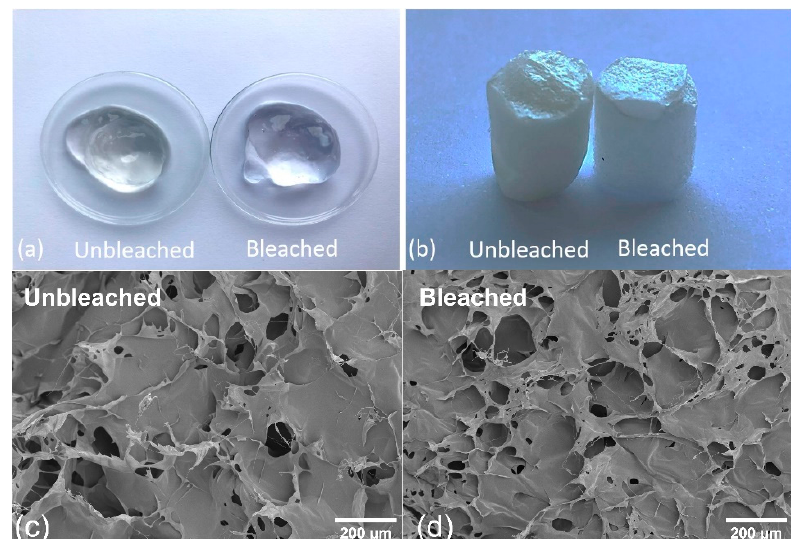
Figure 3. Images of bleached and unbleached CNFs hydrogels ( a ) and freeze-dried aerogels ( b ). The freeze-dried aerogel samples were approx. 5 mm in diameter and 10 mm in height. Note the slightly different yellow color caused by the lignin content in the unbleached CNF sample. SEM images of the unbleached ( c ) and bleached ( d ) freeze-dried aerogels. The SEM images were acquired at 100× magnification.